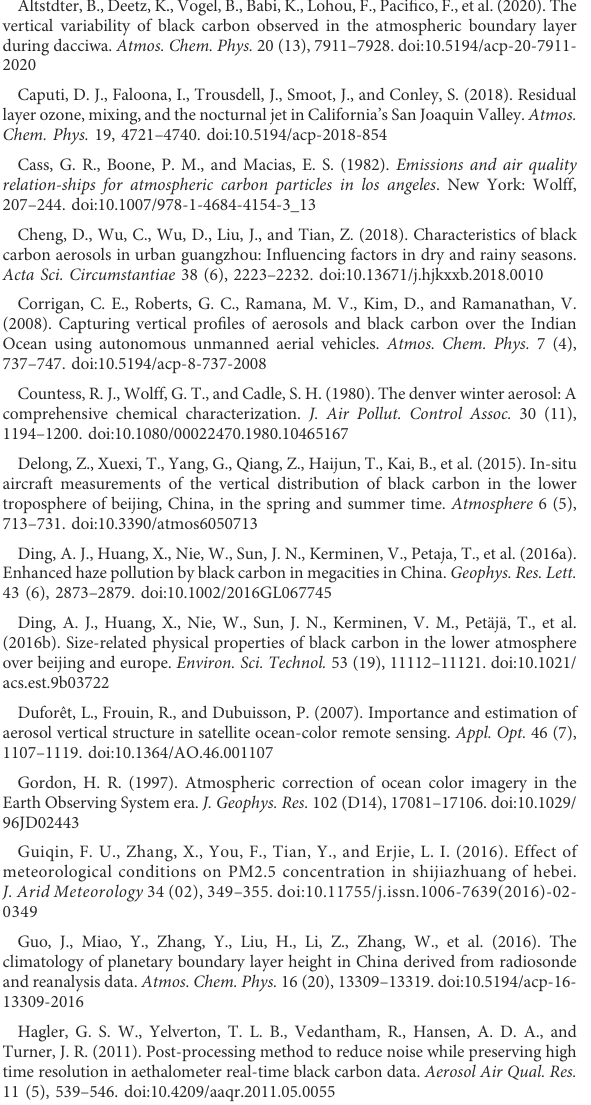
SUPPLEMENTARY FIGURE S1 A tethered balloon and a meteorological sensor. In this observation test, AE- 33 micro-Aethalometer measured ground BC data and AE-51 measured high-altitude BC data. In order to verify the consistency of data quality measured by the two instruments, the two kinds of BC data are compared andveri fi edinthispaper.Inthepreparationstageforthemooredmotorboat to lift off, we turn on the AE-51 collector, so we have a period of time to measureontheground.Weusethegrounddataduringthisperiodoftimeto compare and verify the ground black carbon data measured by AE-33. Supplementary Figure S1 shows the comparison of ground black carbon concentration observed by AE-33 and AE-51 black carbon measuring instruments. The results show that, the correlation coef fi cient of the black carbon mass concentration data after correction by the two instruments reached 0.92, the value difference was small, and the change trend was the same. Therefore, it is believed that the observation results of AE-33 and AE- 51 in this observation test are consistent. SUPPLEMENTARY FIGURE S2